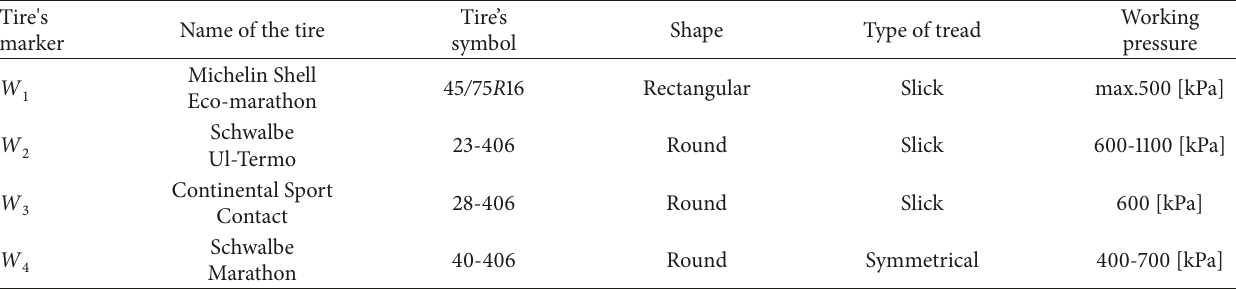
Table 3: The types of tires used in the prototype vehicle.